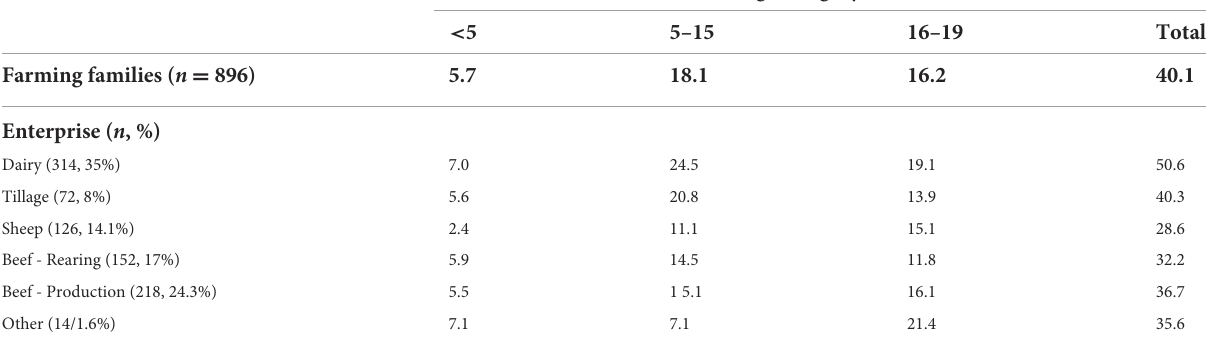
TABLE 1 Percentage of children/ young persons in age cohorts per enterprise on Irish